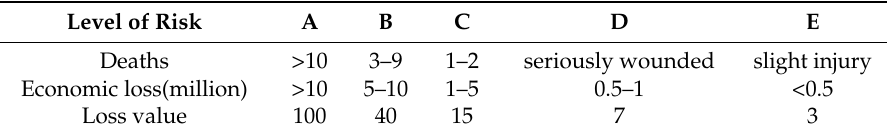
Table 1. Value standard of accident